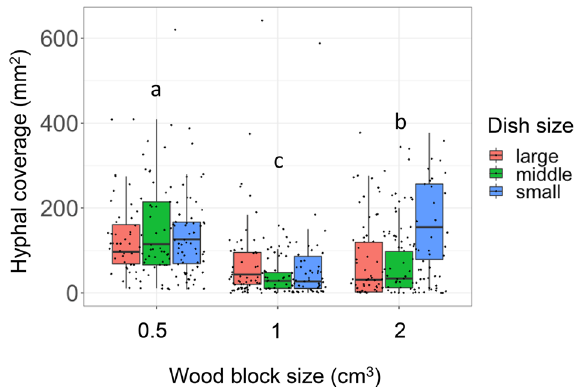
Figure 4. Hyphal coverage (mm 2 ) on unsterilized soil after 27 days of incubation. Different lowercase letters indicate significant differences between wood block sizes (Nemenyi test, P < 0.05). N = 50.